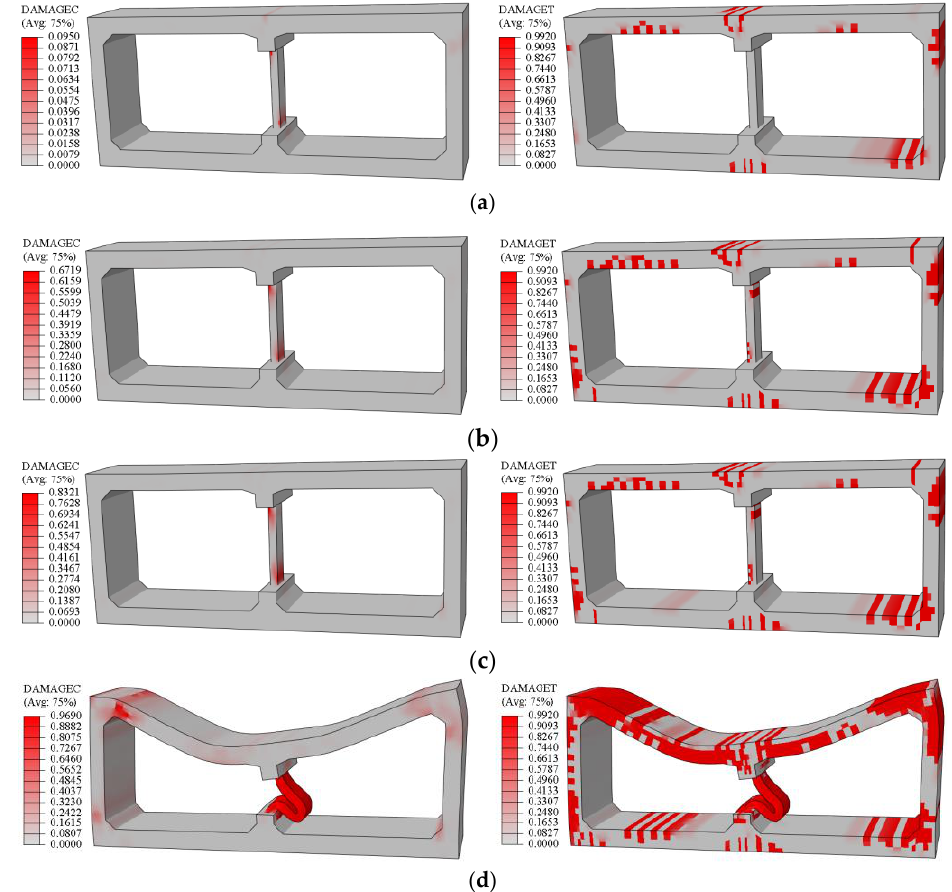
Figure 13. Compressive and tensile damage of the concrete during pushover: ( a ) Stage 1; ( b ) Stage 2; ( c ) Stage 3; ( d ) Stage 4.